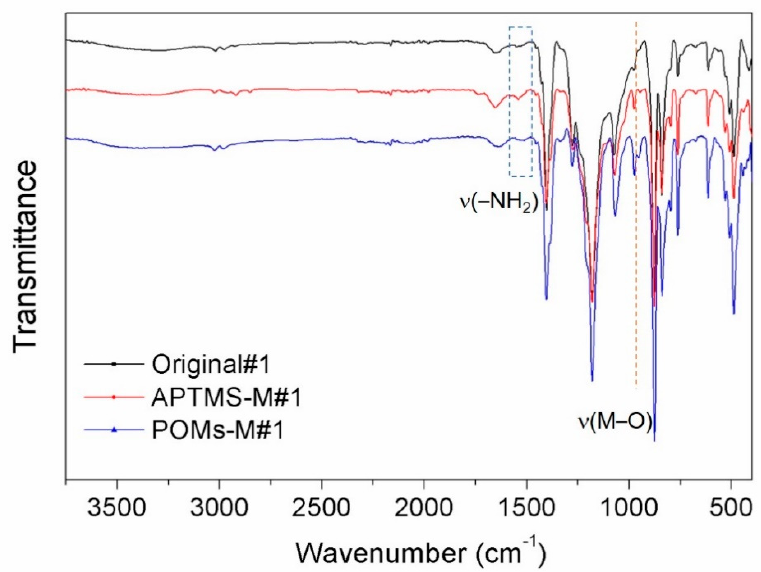
Figure 6. Fourier transform infrared (FTIR) spectra of the original alumina/polyvinylidene fluoride (PVDF) membrane (Orginal#1), the (3-aminopropyl)trimethoxysilane (APTMS)-treated membrane (APTMS-M#1), and the Co mono-substituted Keggin-type [PW 11 O 39 Co(H 2 O)] 4 − (PWCo)-modified membrane (POMs-M#1).